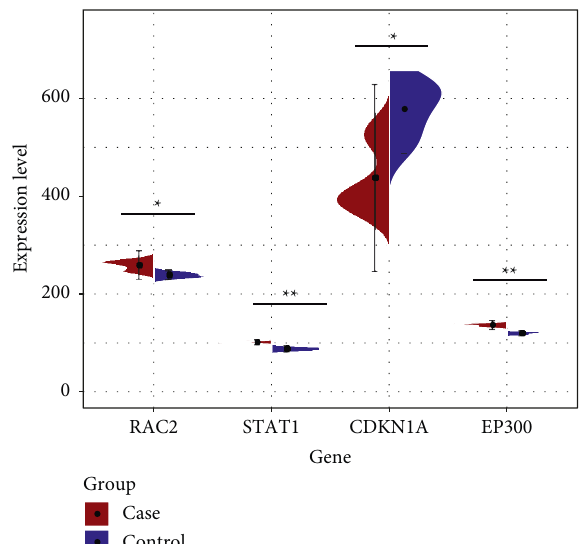
Figure 3: Analysis of hub gene expression in two sets of samples. The horizontal axis is 4 hub genes, and the vertical axis is their expression levels in the case group and the control group. ∗ P < 0 . 05; ∗∗ P < 0 .